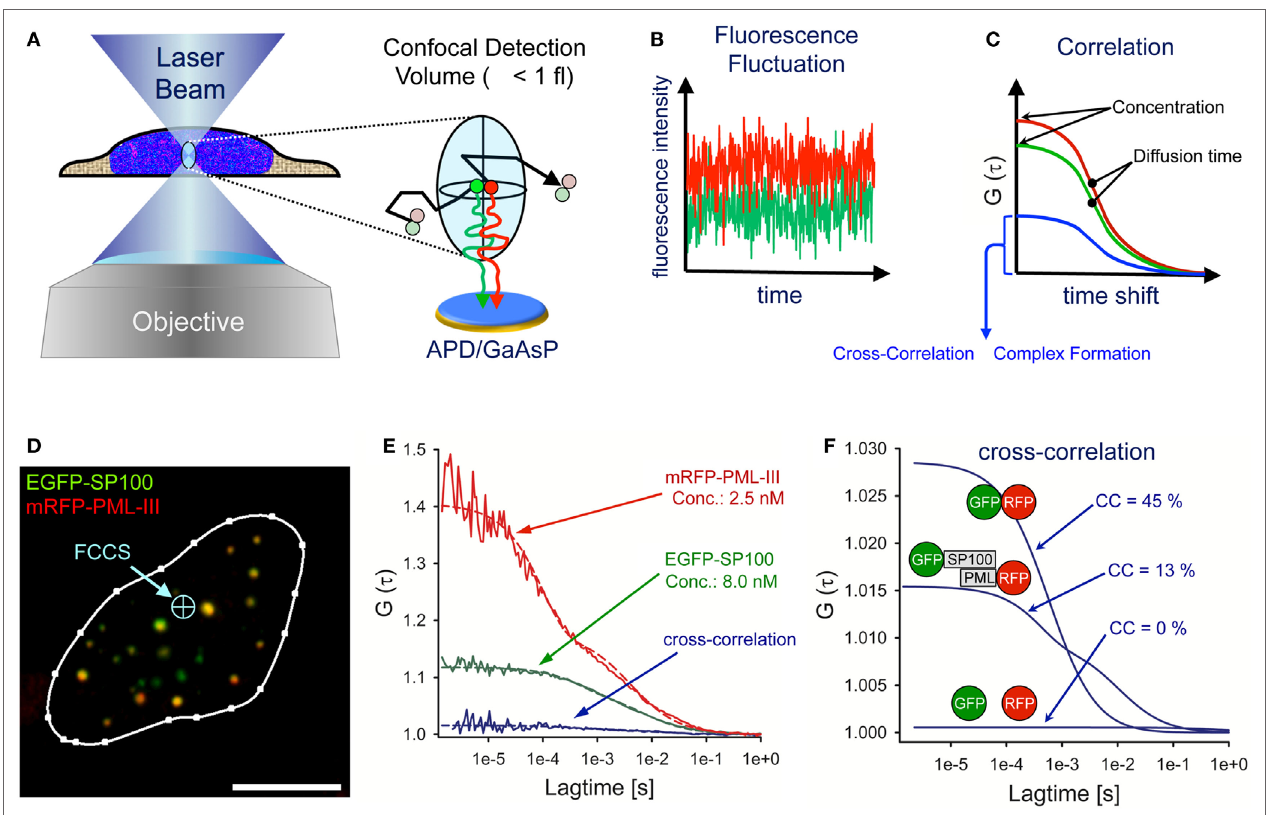
FigURe 5 | Fluorescence cross-correlation spectroscopy (FCCS) analysis of promyelocytic leukemia (PML) nuclear body components. (A) Schematic side view of a living cell with the FCS laser beam focused to a position within the nucleus. The objective creates a laser light-illuminated subfemtoliter measuring volume in which single fluorescent molecules are excited to emit photons. The photons are counted on an avalanche photodiode (APD) or a galliumarsenidphosphid (GaAsP) detector as a time series of fluorescence intensity (B) . These statistical fluctuations are mathematically processed using an autocorrelation algorithm, from which biophysical parameters such as the particle concentration, the diffusion coefficient and complex formation properties can readily be assessed (C) . (D) Confocal live cell image of a U2OS nucleus coexpressing EGFP-SP100 and mRFP-PML-III (bar: 5 µm). The FCCS laser beam (light-blue) can be positioned anywhere in the cell. (e) By fitting the measured FCS data points (solid lines) to appropriate diffusion models (dashed lines), one can extract from the reciprocal of the amplitude and the decay half-time value the number of particles in the detection volume ( concentration ) and the diffusion time , respectively. The cross-correlation (CC) result of EGFP-SP100 and mRFP-PML-III are also shown. (F) CC results in the nucleus of living cells for a GFP–RFP fusion protein (positive control, high CC), GFP and RFP as individual proteins (negative control, no CC) and the measurement performed in (D,e)